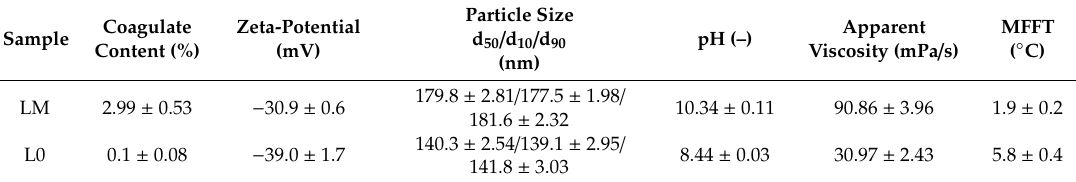
Table 4. Basic properties of evaluated